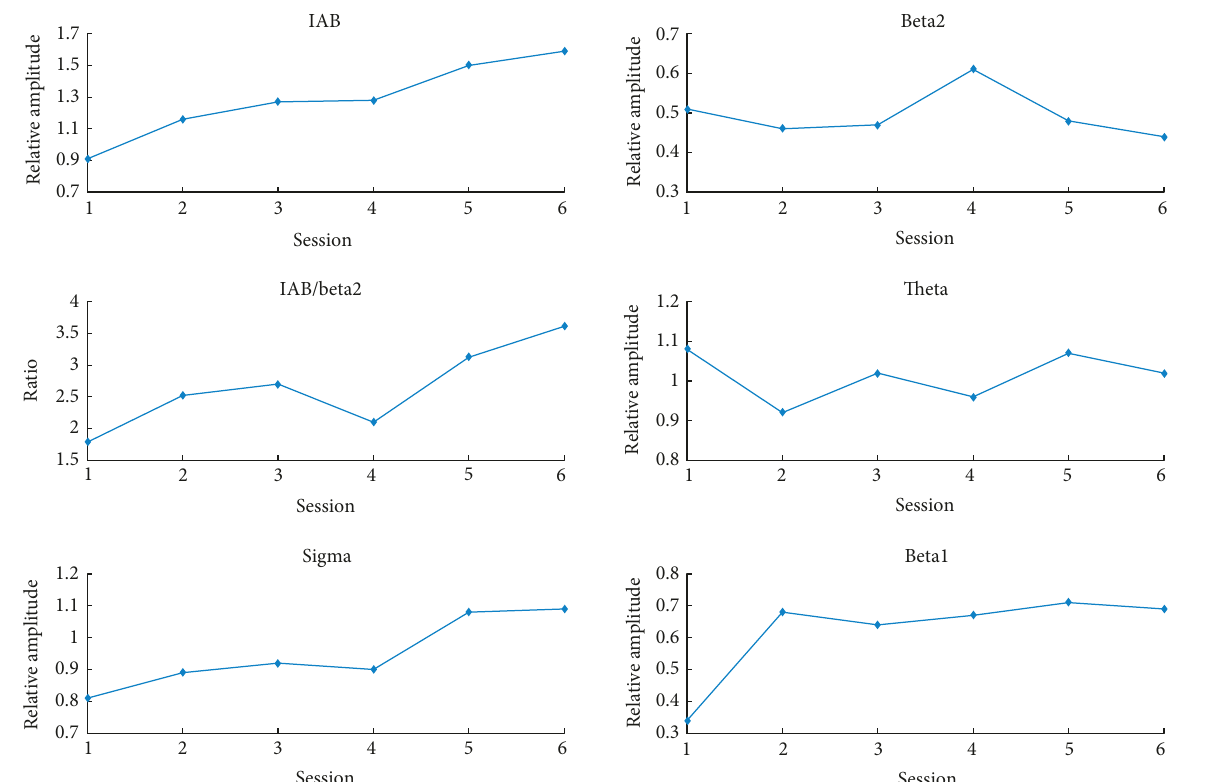
Figure 2: EEG results during NF sessions. Session 1 and session 2 are the user control sessions. Session 3 to session 6 are the fi xed